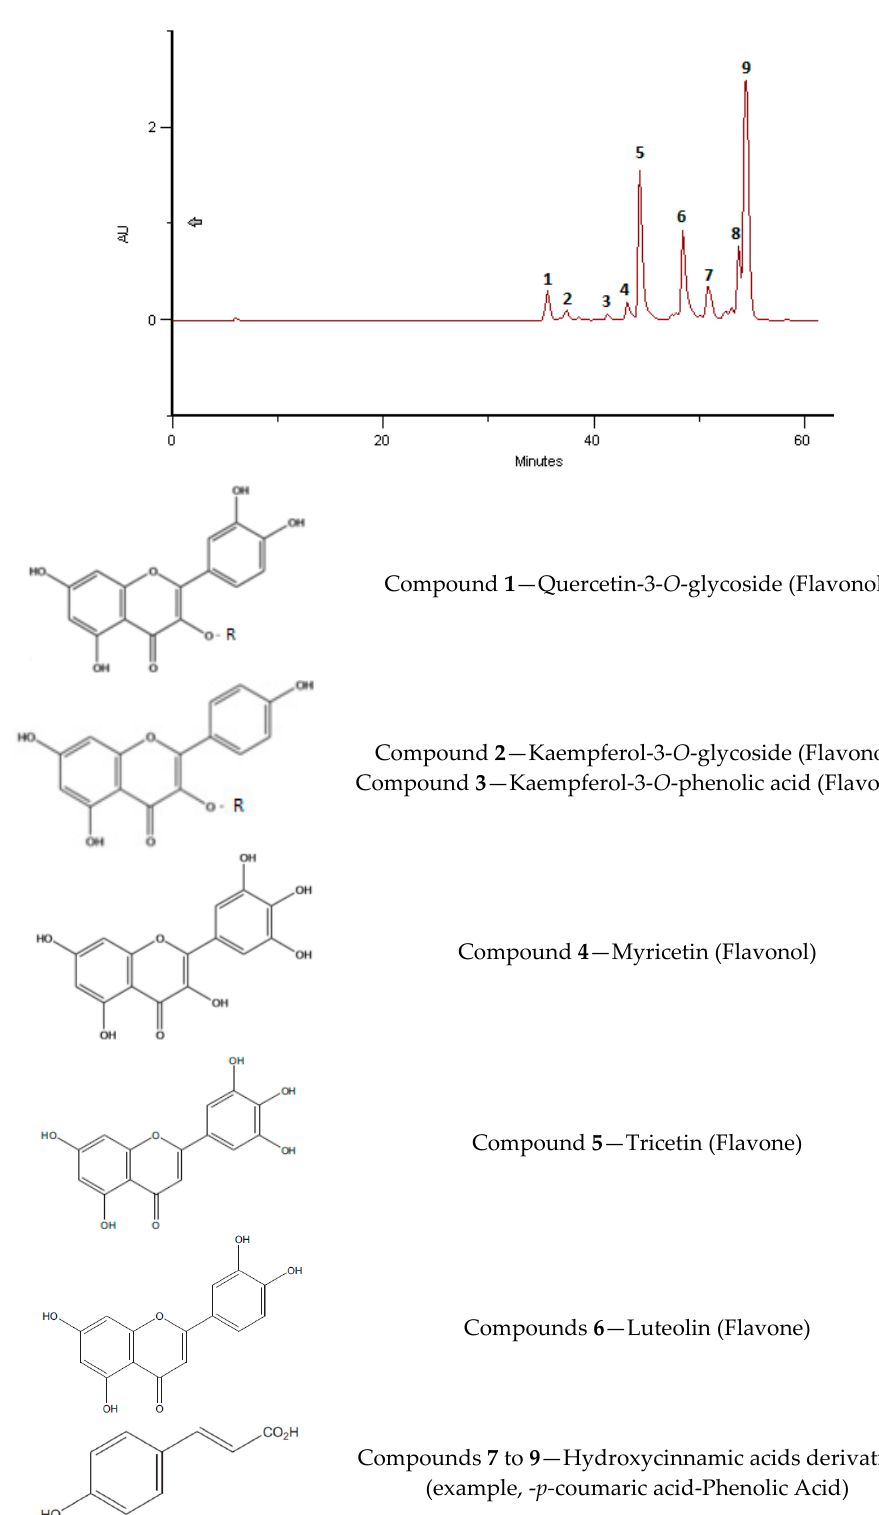
Figure 4. HPLC/DAD profile of BB India, June 2016 that correspond to Eucalyptus sp. (91%), Citrus sp. (7%), Asteraceae (2%). Compound 1 = quercetin-3- O- derivative, compound 2 = Kaempferol-3- O- derivative, compound 3 = Kaempferol-3- O- derivative, probably with a Hydroxycinnamic acids derivative in C3; compound 4 = Myricetin, compound 5 = Tricetin and compound 6 is Luteolin. Compounds 7 – 9 are Hydroxycinnamic acids derivatives (data in line with Campos and Markham [34]).